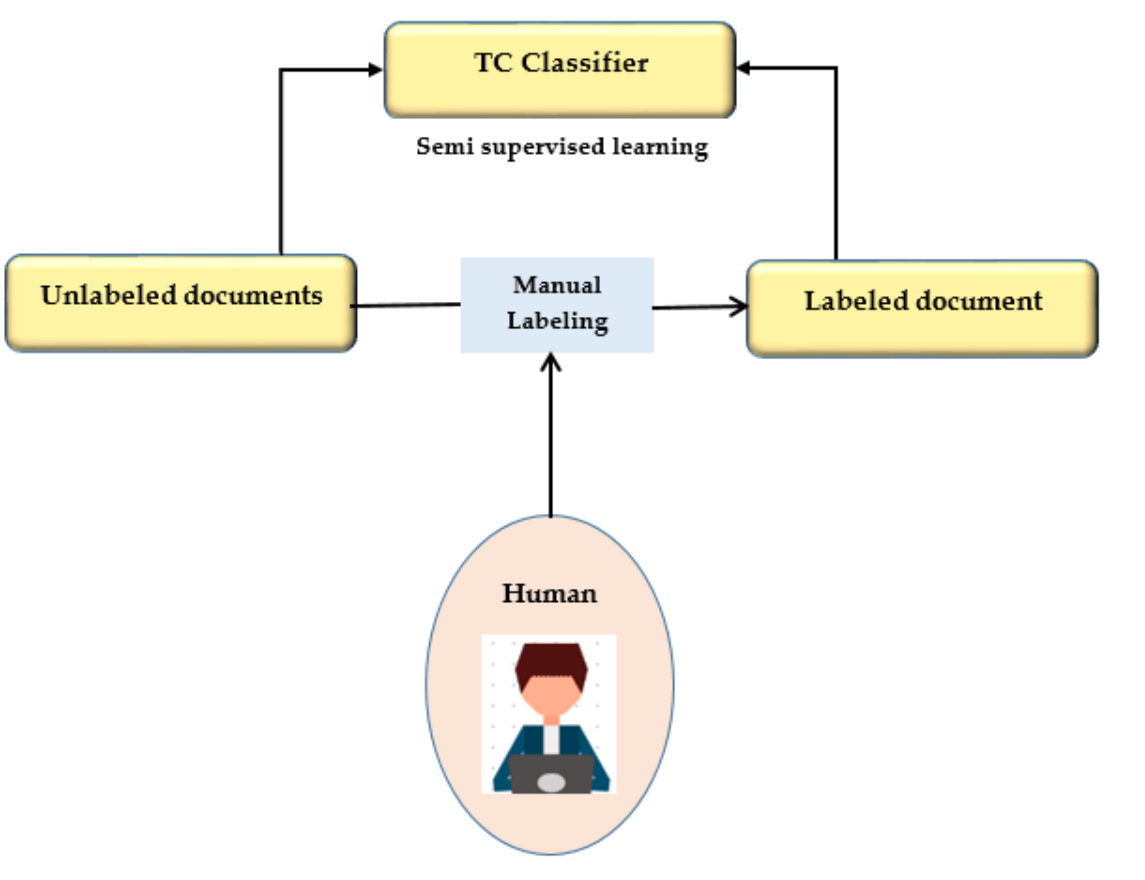
Figure 5. Semi-supervised